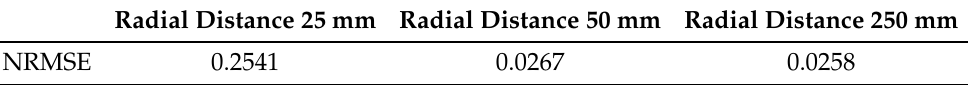
Table 1. Calculated NRMSE